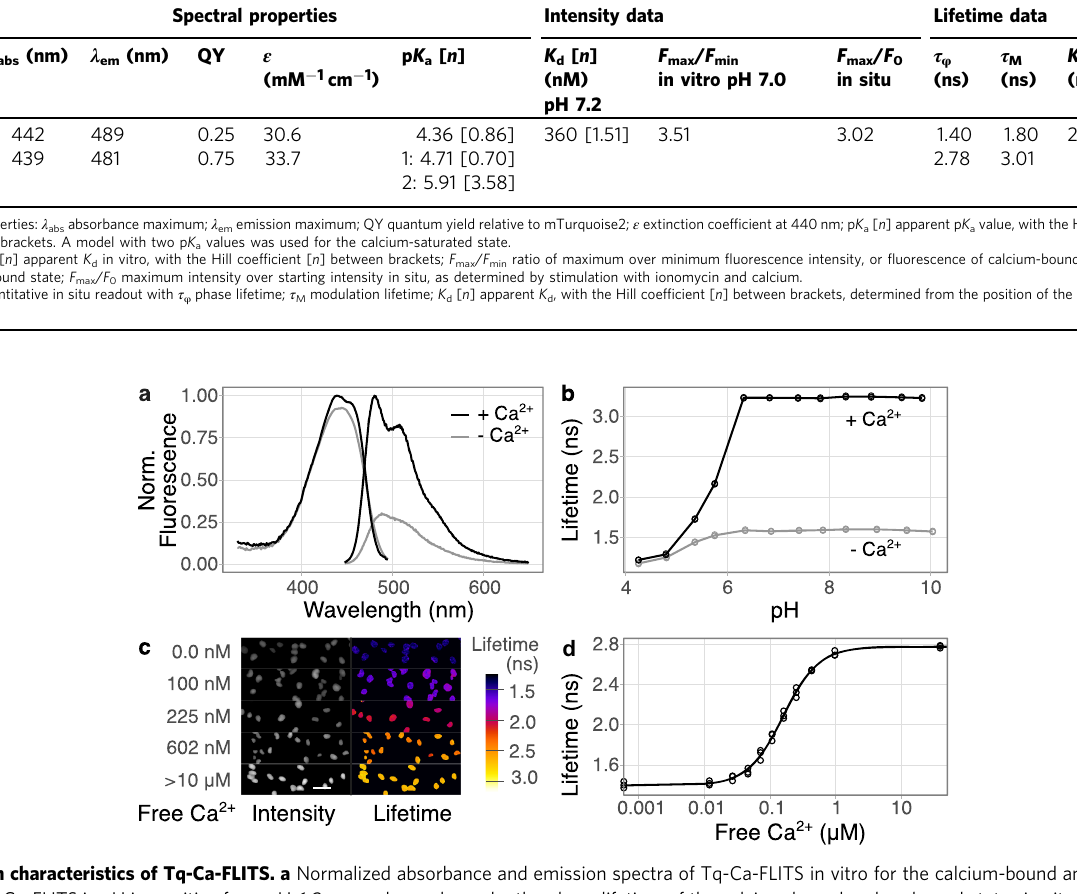
Spectral properties